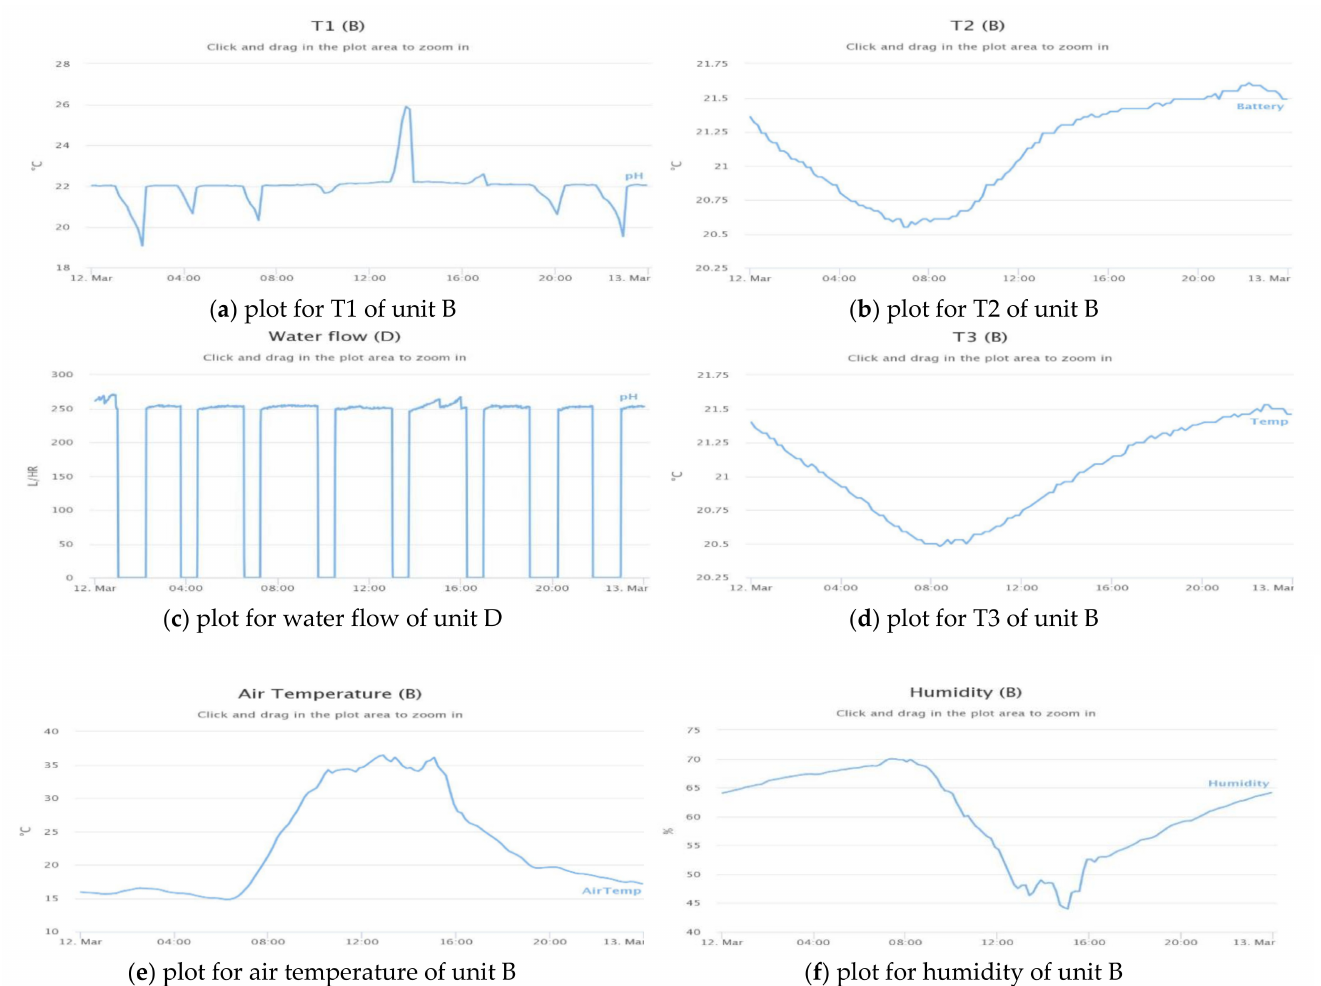
Figure 10. Snapshots of historical environmental